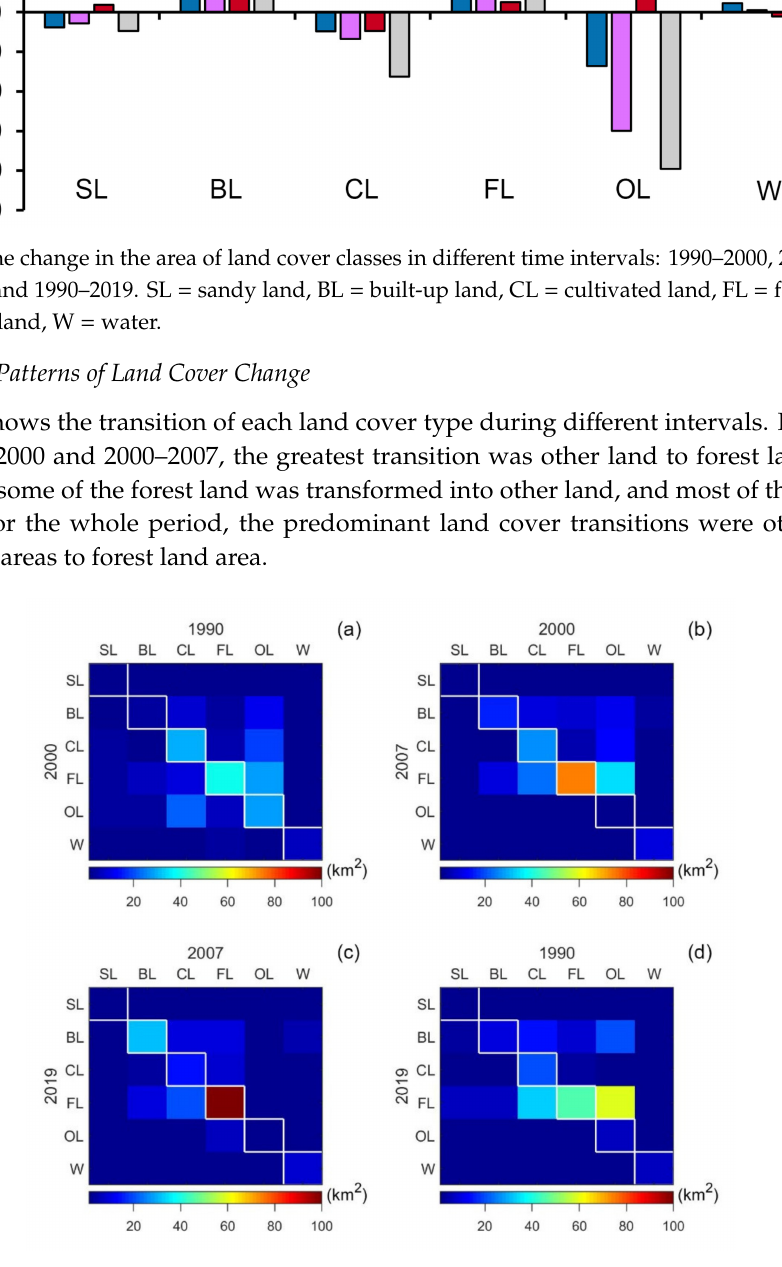
Figure 5. Conversion matrix of land use: ( a ) 1990–2000, ( b ) 2000–2007, ( c ) 2007–2019, and ( d ) 1990–2019. SL = sandy land, BL = built-up land, CL = cultivated land, FL = forest land, OL = other land, W =